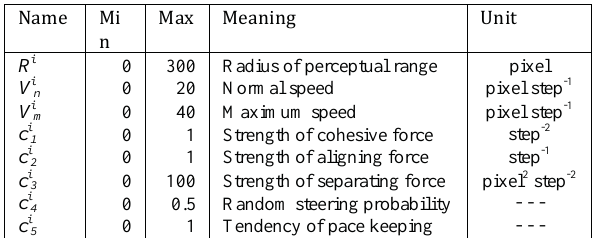
Table 1. Kinetic parameters used to simulate agent behaviour, from Sayama [22]